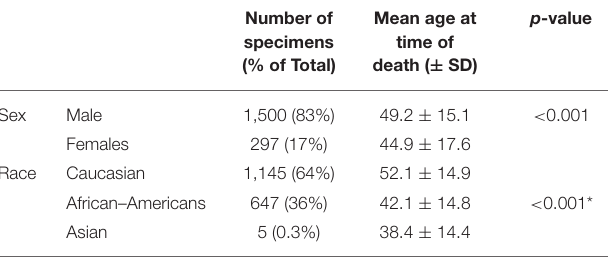
TABLE 1 | Demographics of specimen evaluated during investigation.